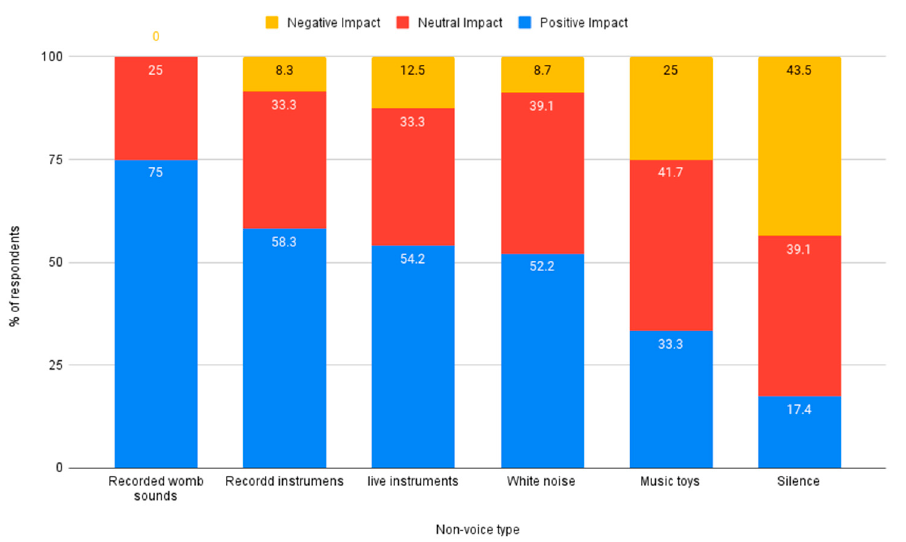
Figure 3. Reported impact of non-voice sounds on auditory development.